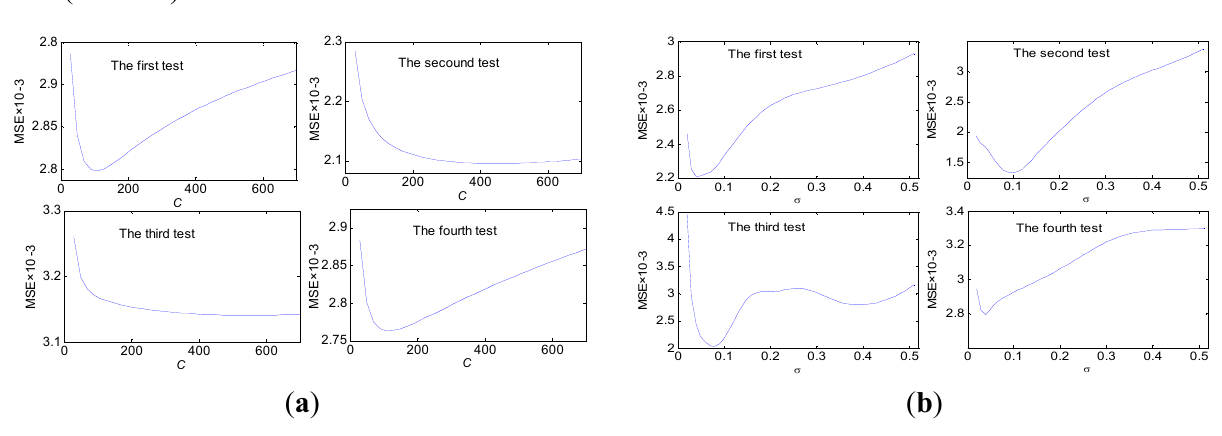
Figure 1. Prediction accuracy versus parameters. ( a ) versus C ( σ = 0.04); ( b ) versus σ ( C = 200).